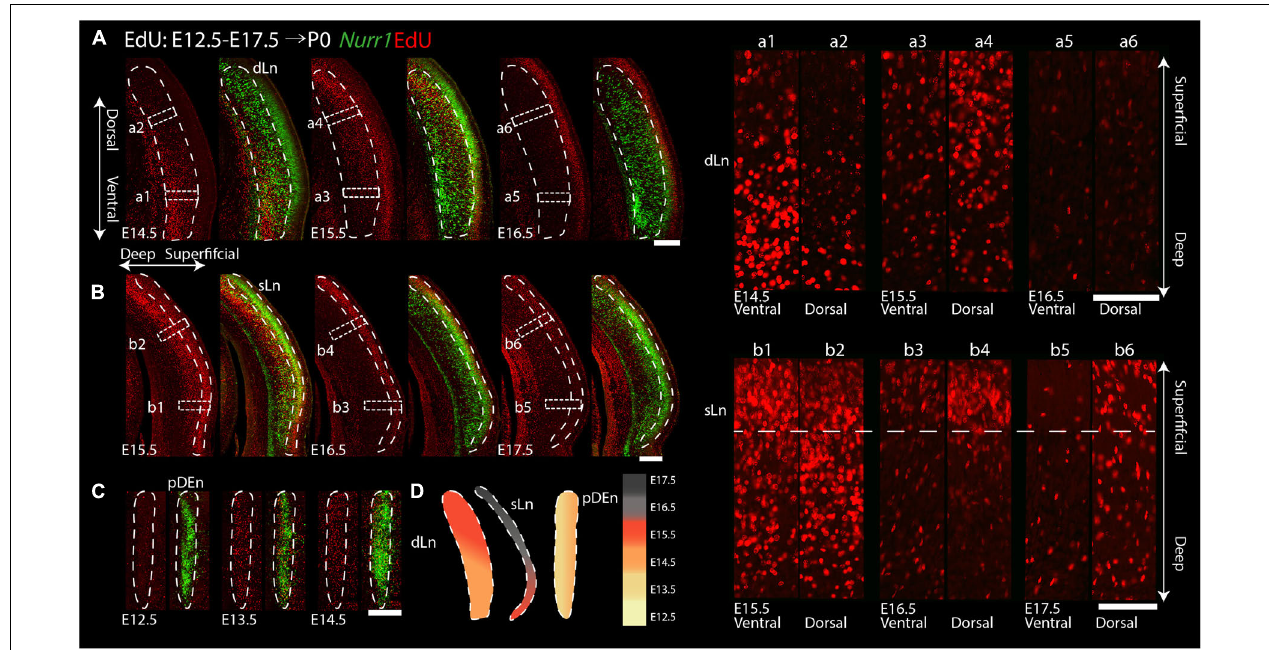
FIGURE 11 | Gradients of neurogenesis in the intermediate and posterior Nurr1 labeled claustrum related regions. High magnification Nurr1 labeled posterior claustrum related regions with E12.5 to E17.5 EdU labeling in the dLn (A) , sLn (B) , and pDEn (C) . Array of crop sections of dLn (a1–a6) and sLn (b1–b6). (D) Schematic diagram of posterior claustrum regions. EdU signals in different regions from E12.5 to E17.5 shown as indicated by the color bar. Scale bar in panel (A–C) = 300 um. Scale bar in panel (a1–b6) = 100